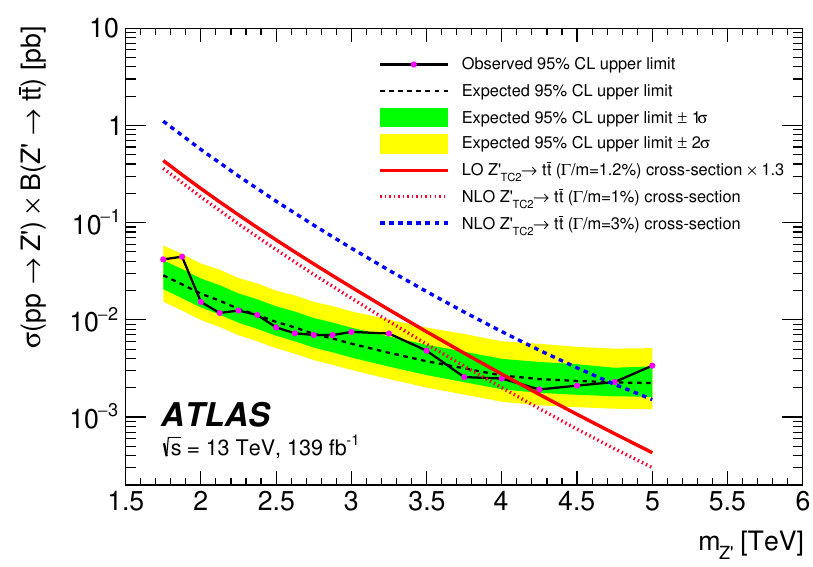
Figure 4. Observed and expected upper limits on the cross-section times branching fraction of the Z 0 ! t (cid:22) t as a function of the Z 0 mass. The NLO theory cross-sections times branching TC2 TC2 fraction for the Z 0 with (cid:0) =m = 1% and 3% are shown by the red dotted and blue dashed lines, TC2 respectively. Shown by the red solid line is a NLO prediction, obtained by multiplying the LO theory cross-section times branching fraction by a factor 1.3 [41], for the Z 0 with (cid:0) =m = 1 : TC2